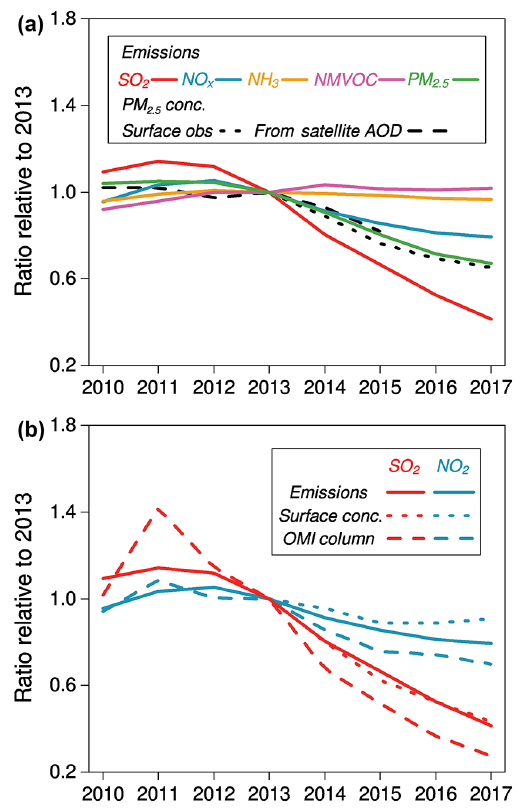
Figure 8. Emission trends compared with satellite- and ground- based observations. The satellite-retrieved PM 2 . 5 concentrations (black, the dashed curve in a ) (Lin et al., 2018) are compared with emission trends of PM 2 . 5 precursors in (a) . The 2010–2017 trends in SO 2 (red, the solid curve in b ) and NO x (blue, the solid curve in b ) emissions are compared with OMI SO 2 (red, the dashed curve in b ) and NO 2 (blue, the dashed curve in b ) tropospheric columns for eastern China, respectively. Eastern China here includes the provinces of Beijing, Tianjin, Hebei, Shanxi, Shaanxi, Shandong, Henan, Hubei, Anhui, Jiangsu, Shanghai, and Zhejiang. The 2013– 2017 trends in ground-based observations of SO 2 (red, the dotted curve in b ), NO 2 (blue, the dotted curve in b ), and PM 2 . 5 (black, the dotted curve in a ) are also presented. Data are normalized by di- viding the value of each year by their corresponding value in